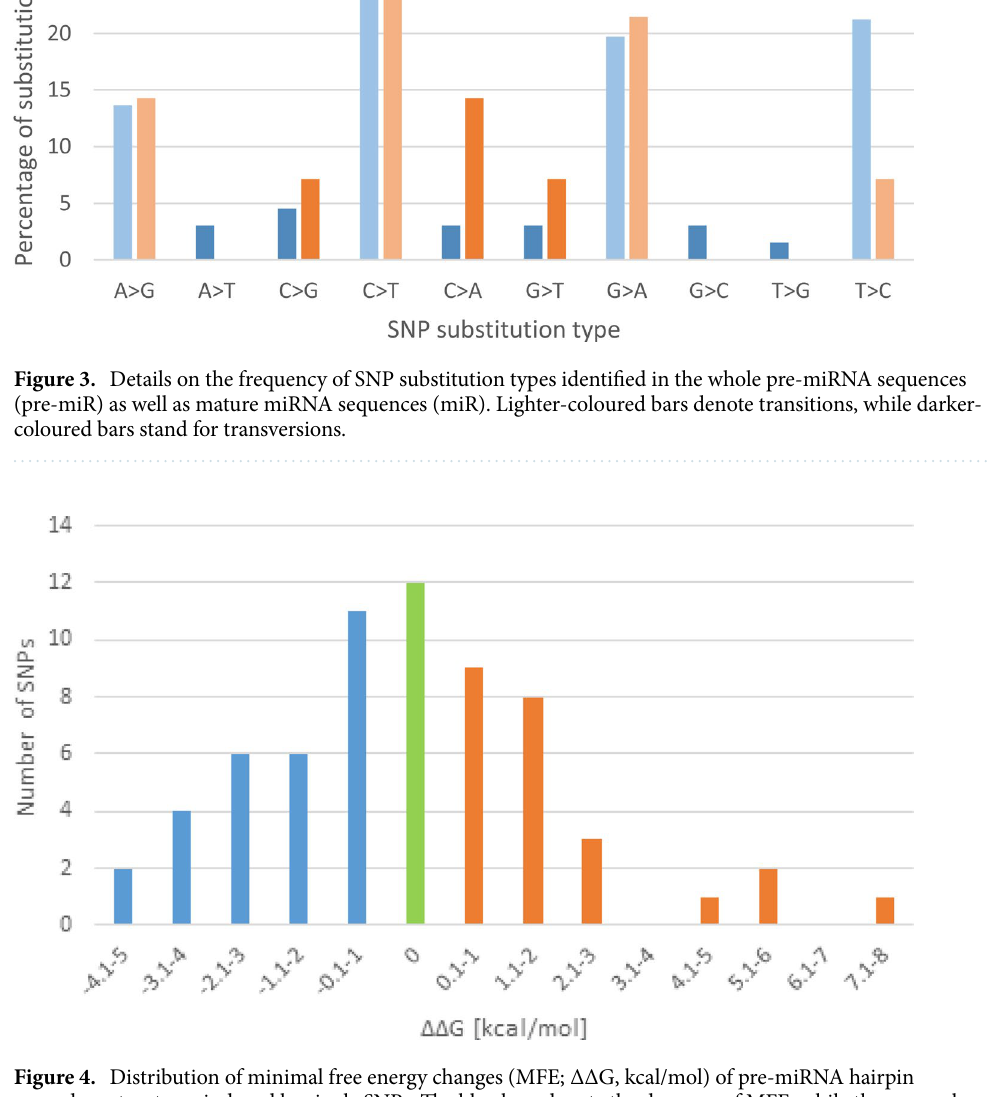
Figure 4. Distribution of minimal free energy changes (MFE; ΔΔG, kcal/mol) of pre-miRNA hairpin secondary structures induced by single SNPs. The blue bars denote the decrease of MFE, while the orange bars denote the increase of